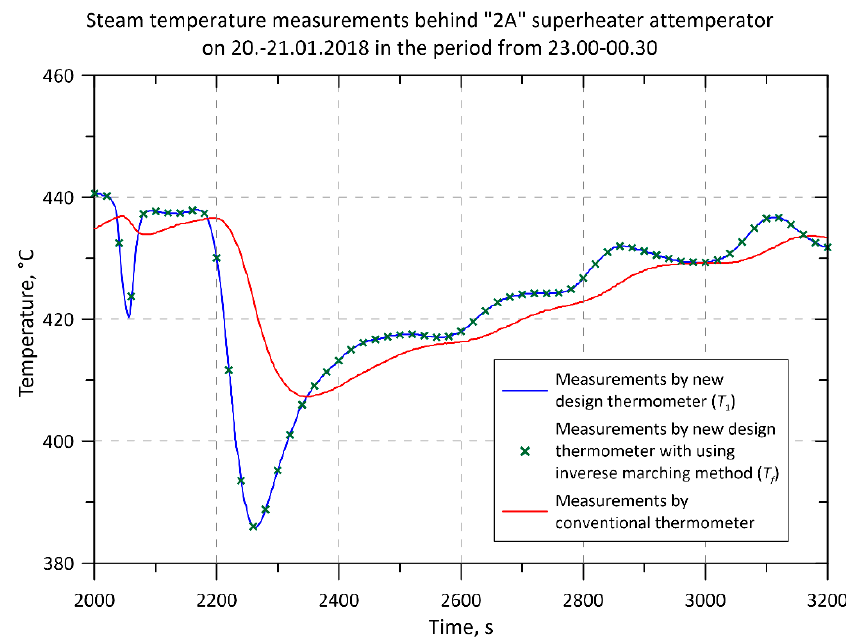
Figure 5. Comparison of superheated steam temperature downstream of the second superheater attemperator measured on side “A” in the K8 boiler by conventional and new design thermometers (selected fragment).